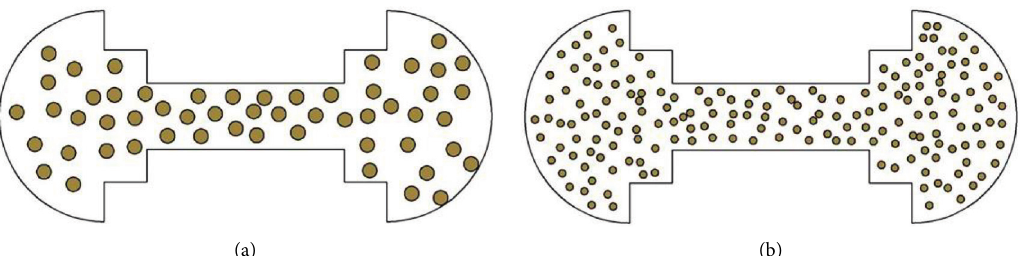
Figure 5: AR specimens with different CR particle sizes. (a) AR specimen with coarse CR particles and (b) AR specimen with fine CR particles.